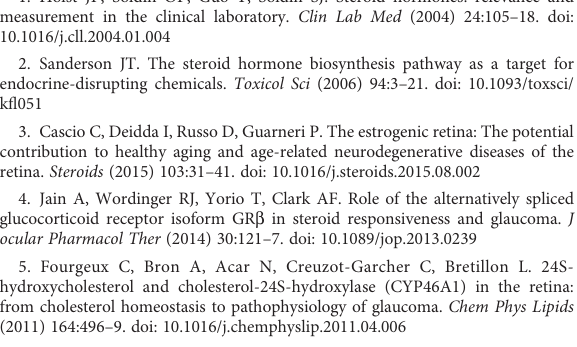
SUPPLEMENTARY FIGURE 3 The leave-one-out results of steroid hormone for AMD in the discovery stage. SUPPLEMENTARY FIGURE 4 The leave-one-out results of steroid hormone for glaucoma in the replicated